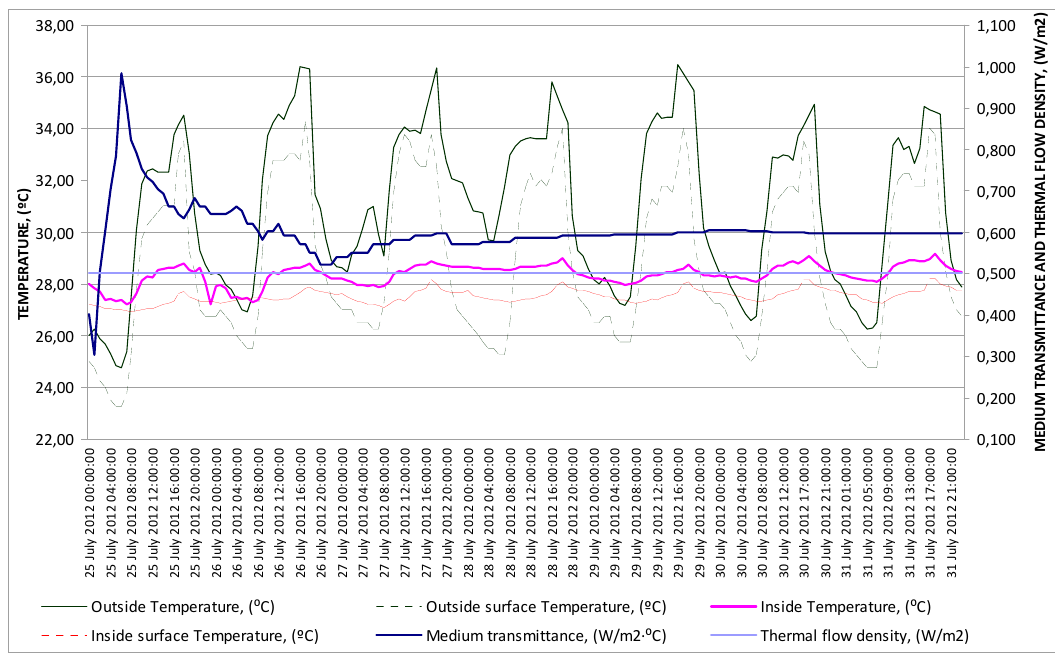
Figure 13. The thermal flow measurement graph with the temperature and flow data used to calculate the U -value. Table 5. The U- values obtained in the different scenarios. Fourier UNE Fourier Mathis TCi Monitoring C 1 Monitoring C 2